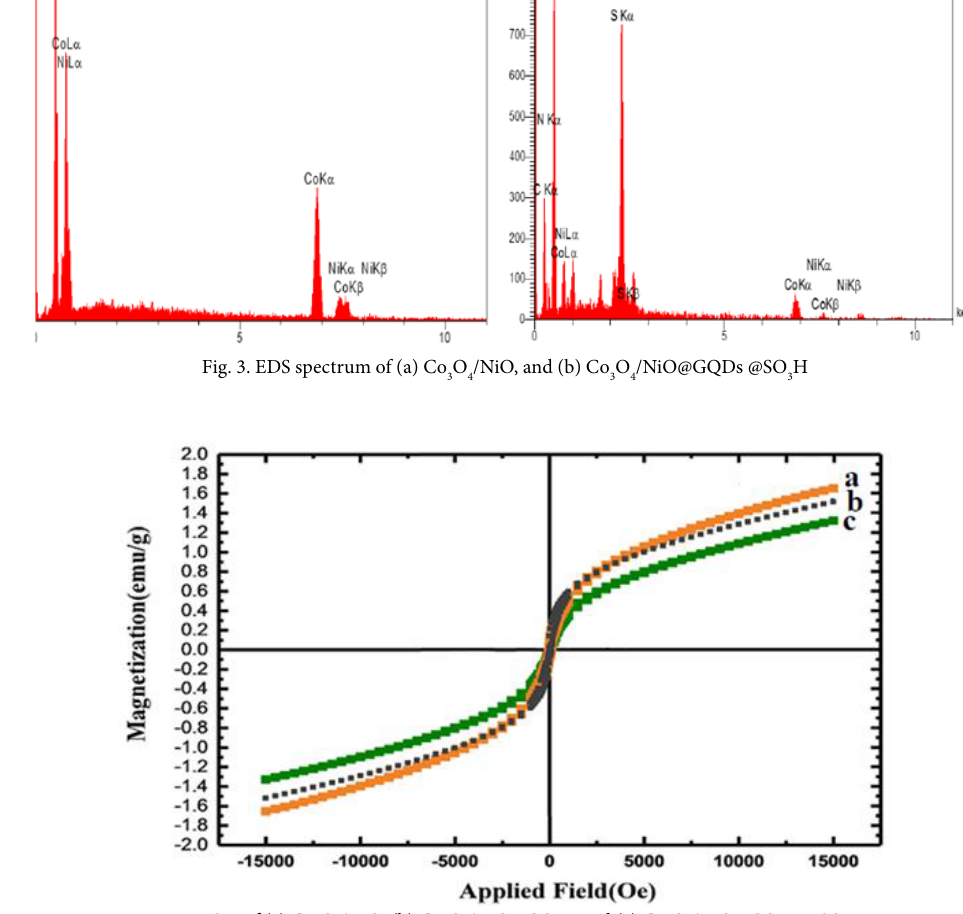
O /NiO@GQDs @SO 3 4